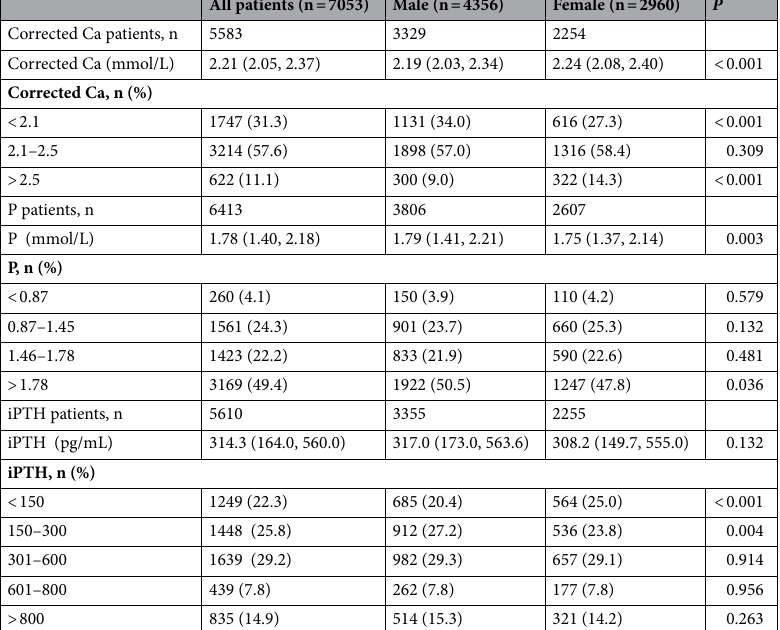
Table 4. The levels of Ca, P, and iPTH in different-gender groups.